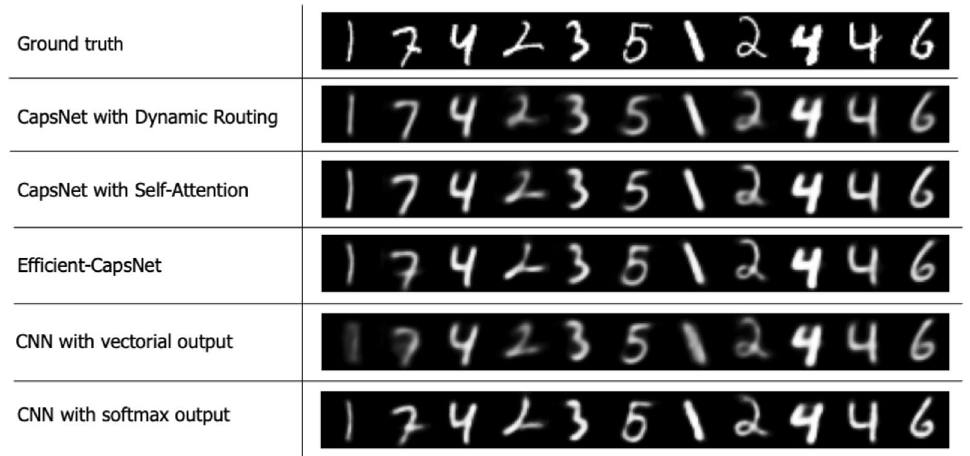
Figure 5. Digit reconstruction with different tested methodologies. Even with different architecture strategies and training objectives, all networks are able to embed different properties of the input digits keeping only important